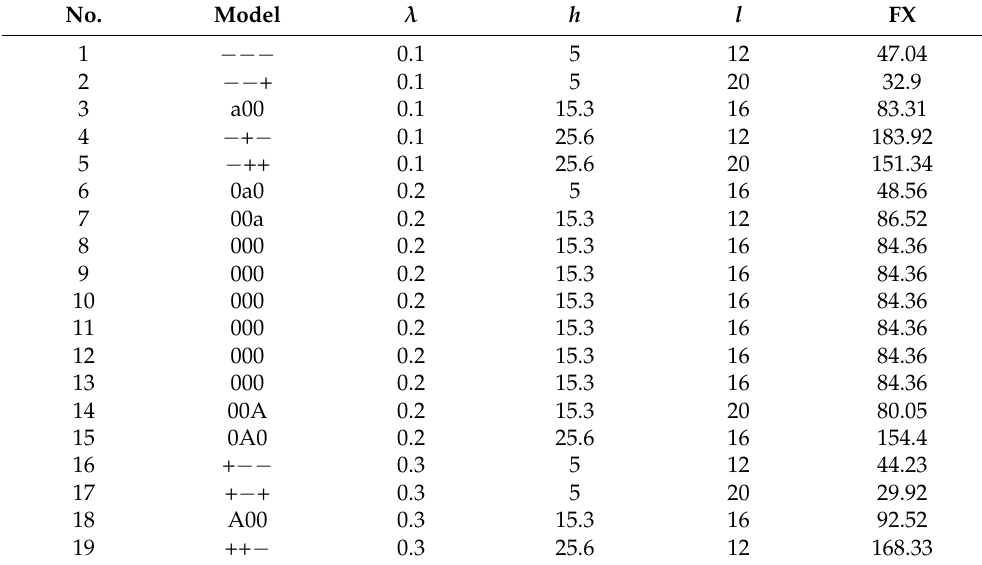
Table 5. The response surface experimental design.